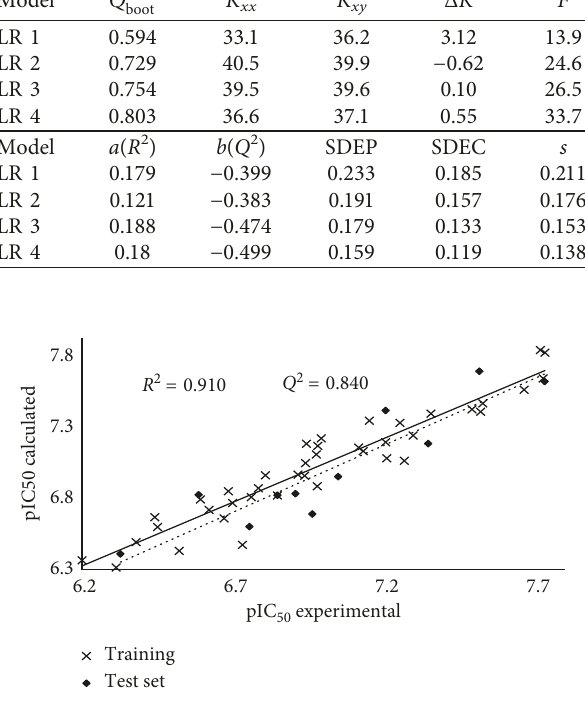
Figure 2: Graphical plot between experimental and calculated pIC 50 by